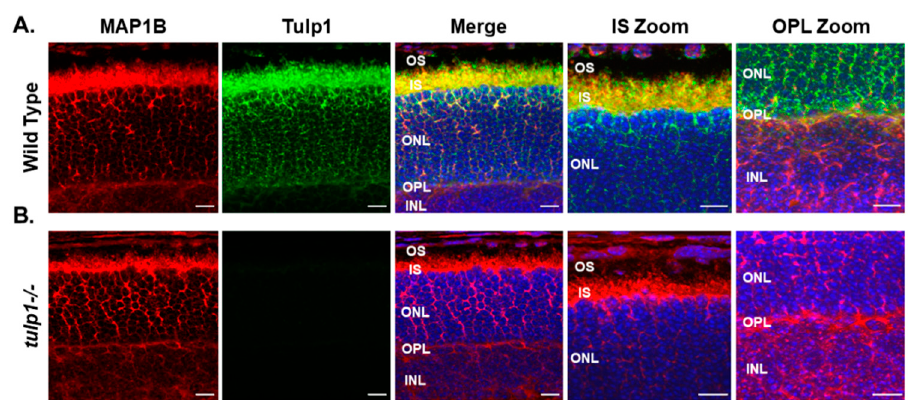
Figure 3. Immunolocalization of MAP1B and Tulp1 in P17 mouse retinas. ( A ) Wt retinal sections stained with MAP1B (red) and Tulp1 (green). ( B ) Tulp1 − / − retinal sections stained with MAP1B (red) and Tulp1 (green). Sections were counterstained with DAPI (blue). Scale bar: 50 μ m. INL, inner nuclear layer; OPL, outer plexiform layer; ONL, outer nuclear layer; IS, inner segment layer; OS, outer segment layer.